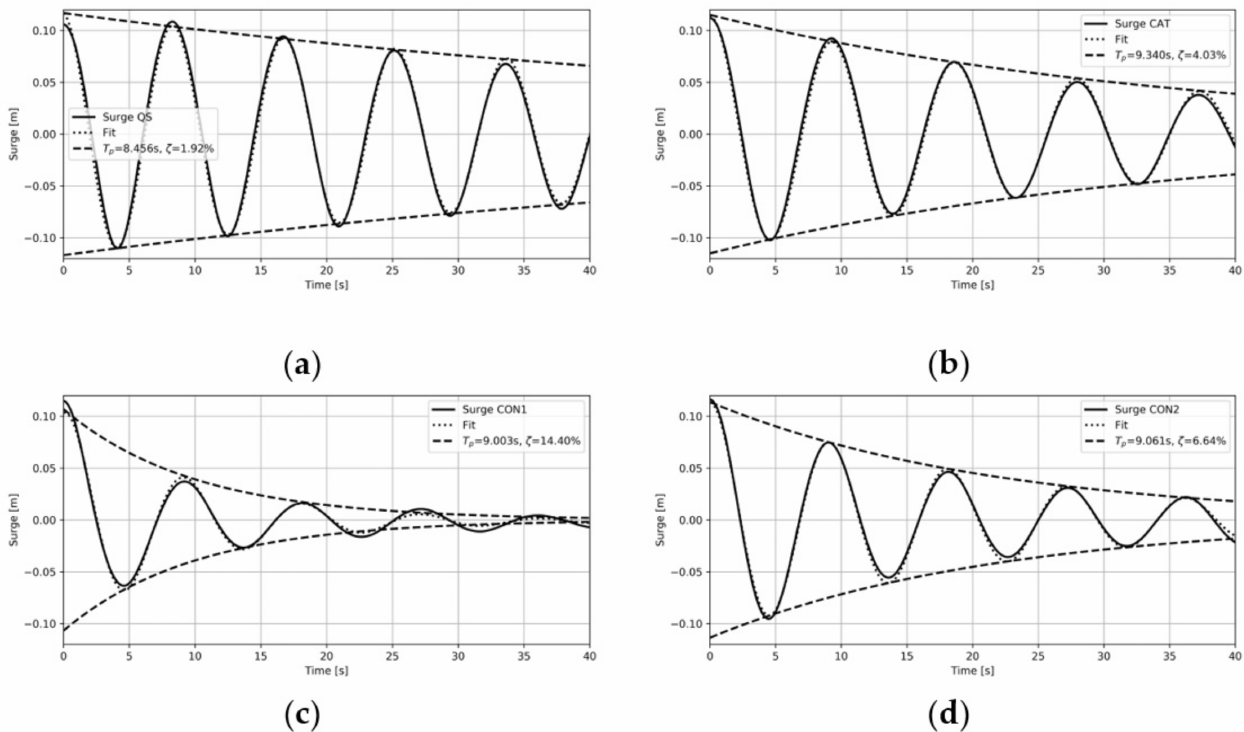
Figure 19. Time series to estimate the natural period and percentage of critical damping for the decaying surge motion of the buoy with mooring system: ( a ) QS; ( b ) CAT; ( c ) CON1, ( d ) and